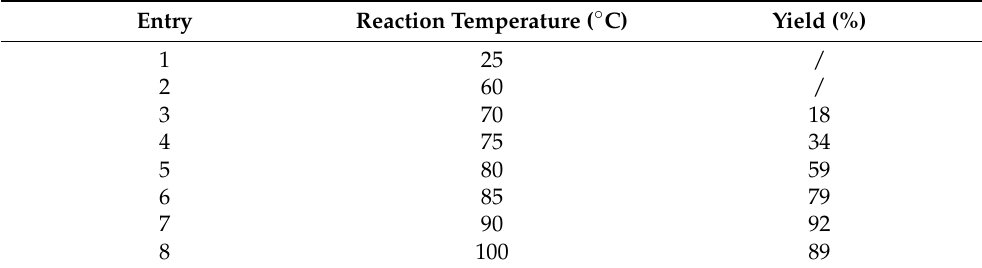
Table 3. Temperature effect on the polymerization carried out under N 2 atmosphere for 24 h